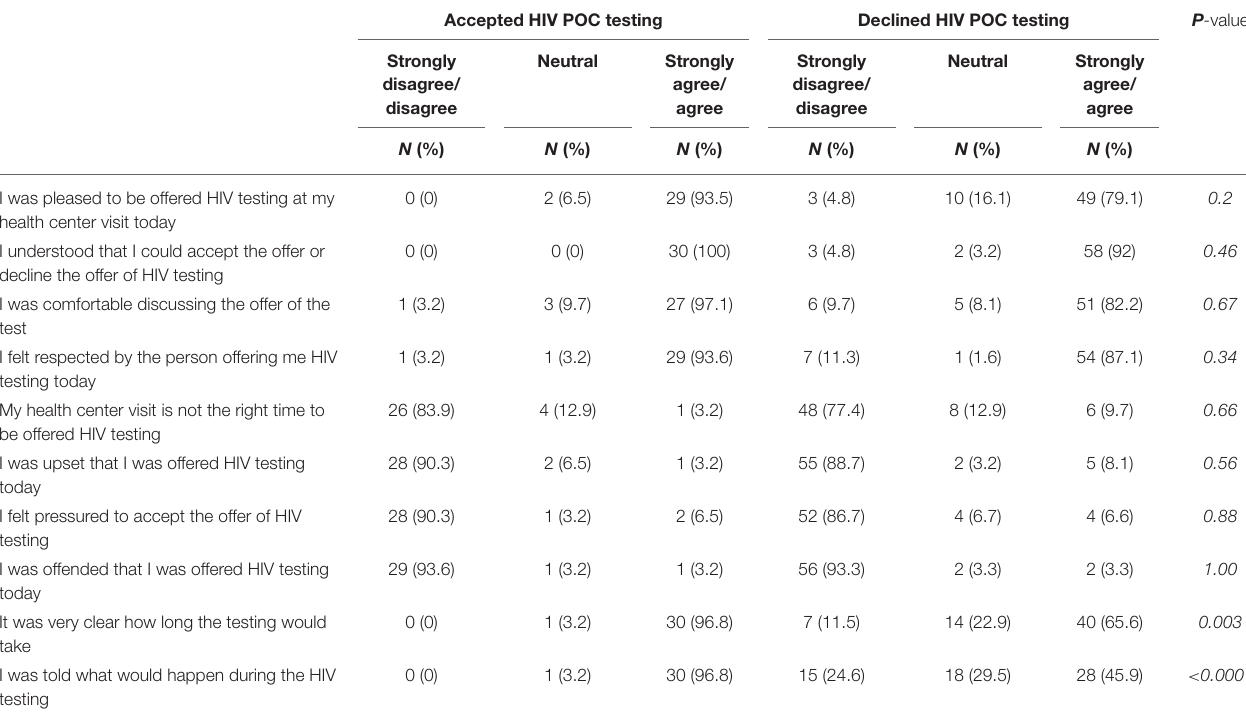
TABLE 3 | Patients’ Perspectives on Being Offered an HIV POC Test at their Health Services Appointment by Decision to